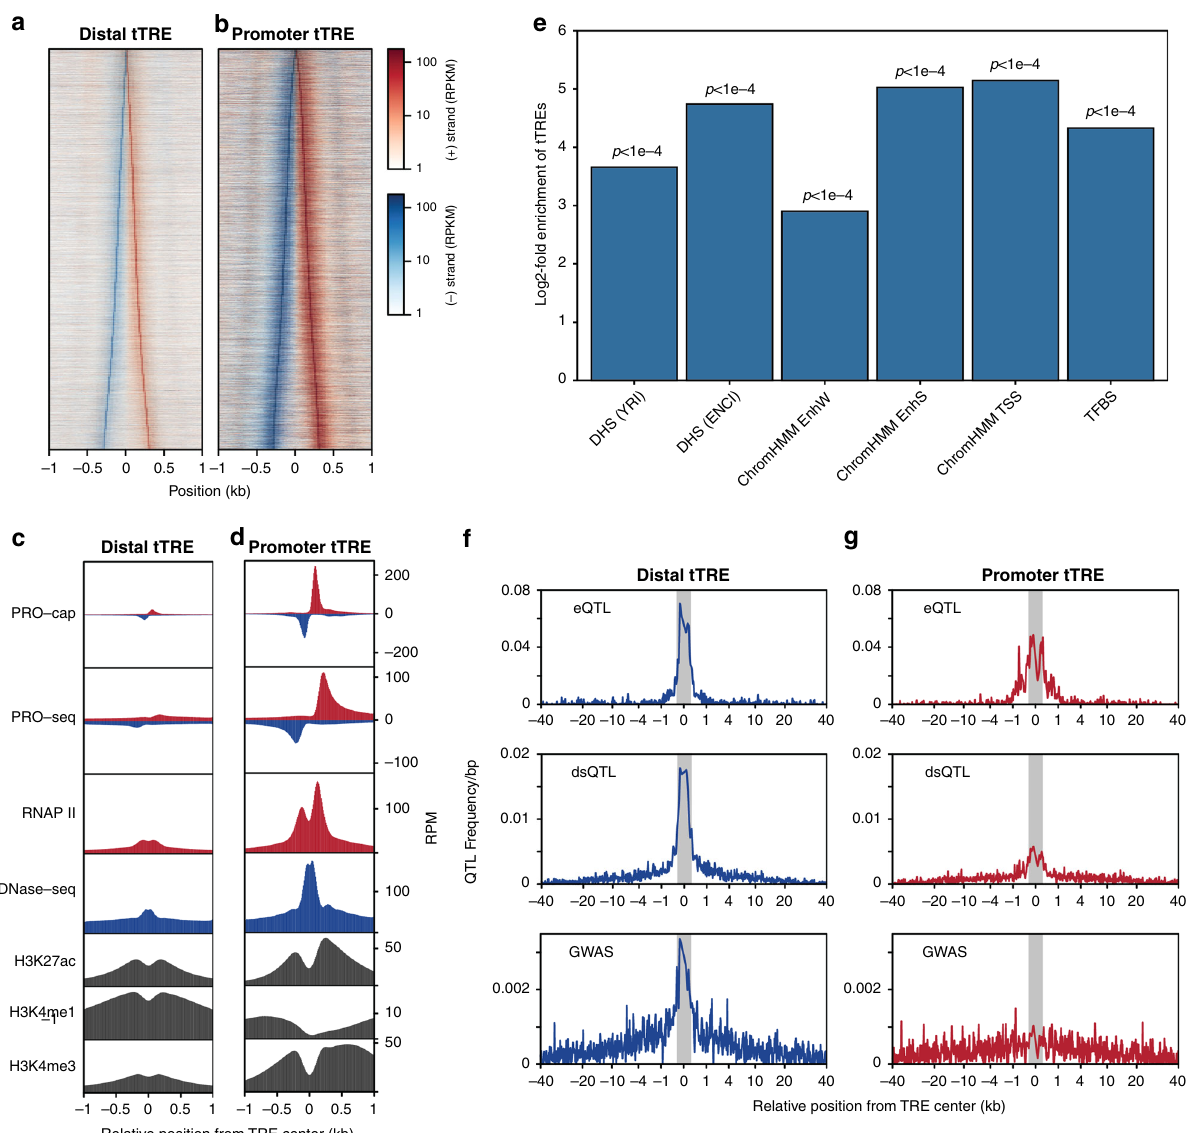
Fig. 2 tTREs contain important regulatory information. a PRO-cap signal at enhancers. Heatmap shows plus-strand (red) and minus-strand (blue) read counts at distal tTREs (putative enhancers), ordered by increasing width. b As in a at promoter tTREs. c PRO-cap-identi fi ed tTREs have characteristic promoter and enhancer chromatin patterns. Metaplots of PRO-cap, PRO-seq, DNase-seq and RNAP II, H3K27ac, H3K4me1, and H3K4me3 ChIP-seq signals at enhancers (Distal tTRE). d As in c at promoter tTREs. Promoters are oriented in the direction of the gene. e Enrichment of tTREs in regulatory regions. DHS (YRI): DNase I hypersensitive windows from the Yoruba LCLs ( n = 630,168), DHS(ENC): DNase I hypersensitive sites from ENCODE LCLs (including GM12878; n = 359,361), TFBS: de fi ned by ENCODE Factorbook in GM12878 ( n = 212,144). ChromHMM: regions de fi ned by ChromHMM as weak enhancers (EnhW; n = 70,620), strong enhancers (EnhS; n = 19,362), and transcription start sites (TSS; n = 21,342) in GM12878. GAT computes an empirical, one-sided p -value de fi ned as the number of sampled segments that show an equal or greater overlap than the observed overlap. P -values are adjusted by Benjamini-Hochberg correction, sampling n = 10,000. f Frequency of genetic variants associated with gene expression (eQTLs), chromatin accessibility (dsQTLs), and human disease (GWAS) at enhancer tTREs. Both the eQTLs and dsQTLs are derived from the same set of LCLs used in this paper. Shaded regions indicate tTRE boundaries. g As in f at promoter